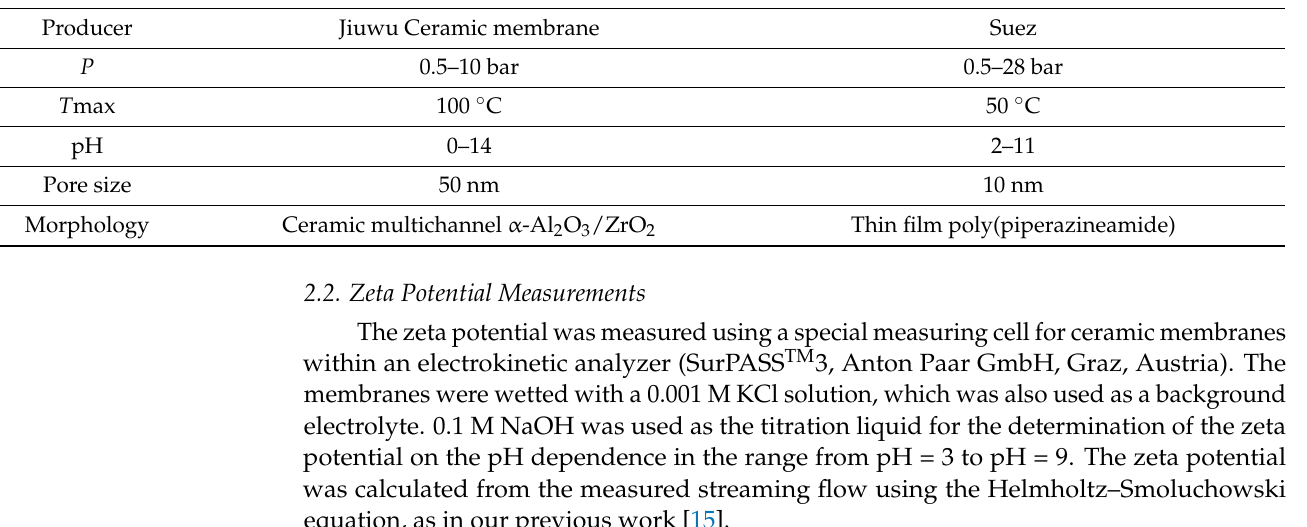
Table 1. The UF and NF membranes’ characteristics.